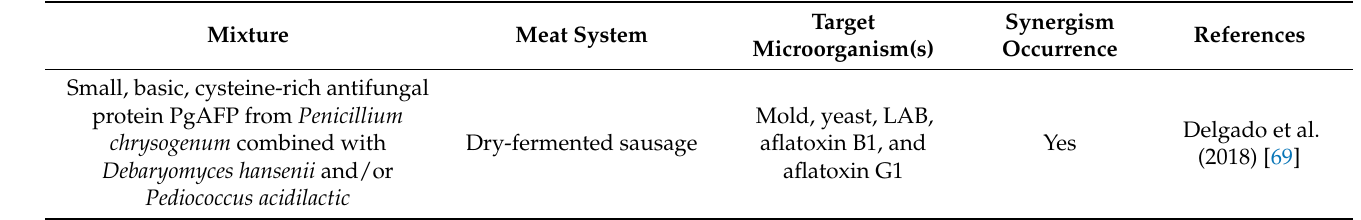
Table 8. The use of a combination of PgAFP with protective cultures against different target microor-